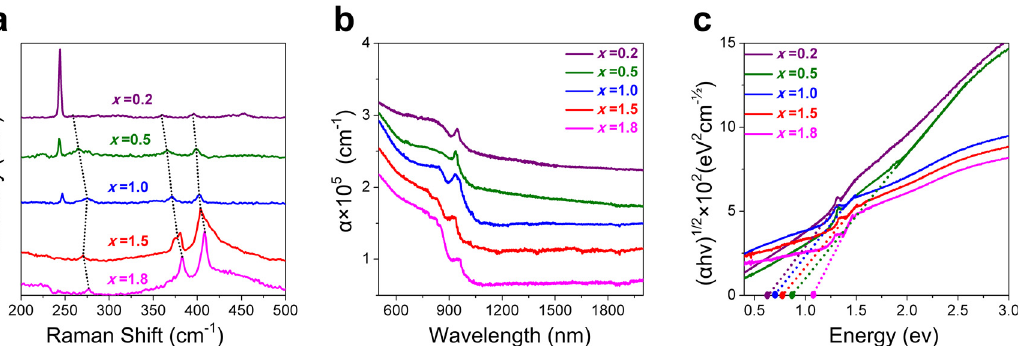
Figure 4: The Raman and linear absorption measurements. (a)RamanspectraofMoS x Se 2 − x alloyswithScomposition x from0.2to1.8.(b)UV-VIS-NIRabsorptioncoef fi cientfortheMoS x Se 2 − x withvarious S/Se ratios. (c) The graph of ( α hv ) 1/2 versus hv of MoS x Se 2 − x ( x = 0.2, 0.5, 1.0, 1.5 and